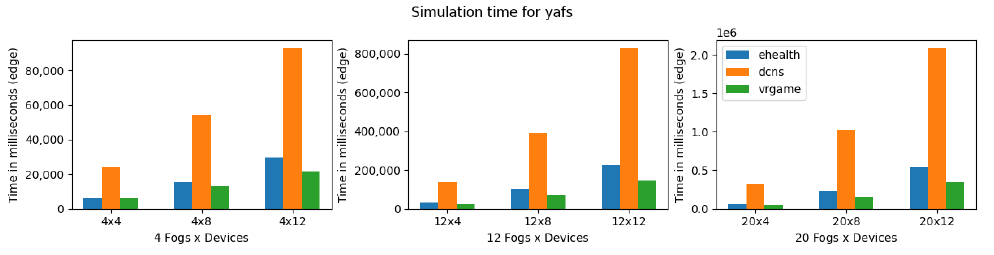
Figure 16. Execution time for YAFS.